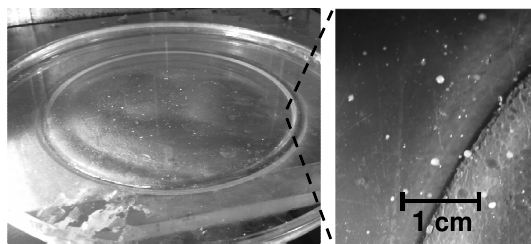
Figure 1. Images of crystals once they have grown on the sugar solution.